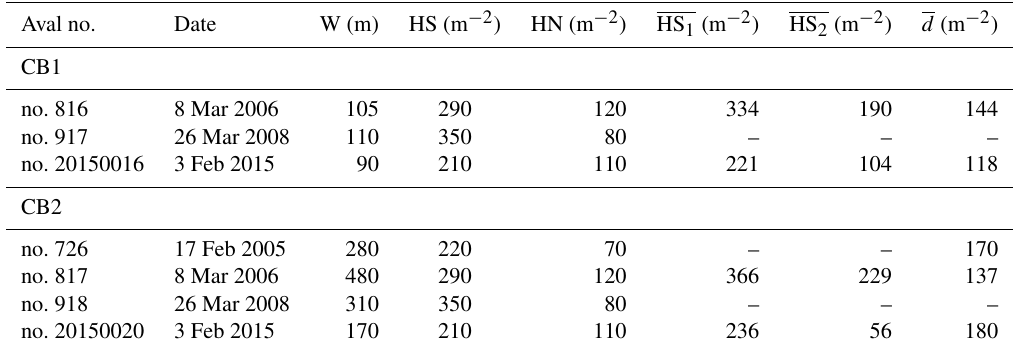
Table 2. Number, date, release area width ( W ), snow depth (HS) and new snow depth (HN) measured at the weather station of Donin du Jour; mean snow depth before (HS 1 ) and after avalanche release (HS 2 ) and mean fracture depth ( d ) for avalanche release areas occurring from the winter season 2005/2006 onwards. Aval no.